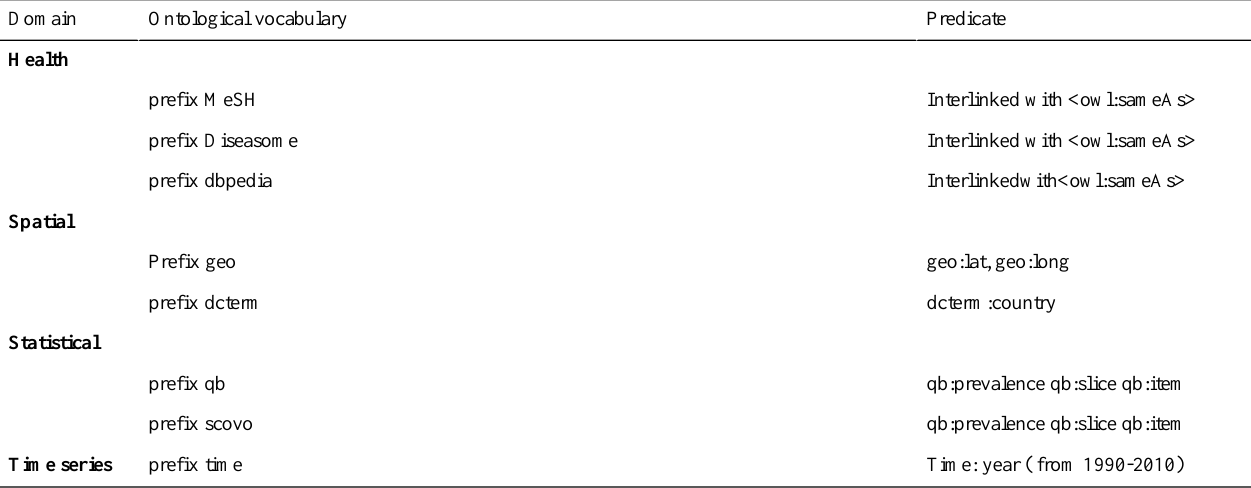
Table 1. Different domain ontological vocabularies and predicates reused for modeling data in the conversion